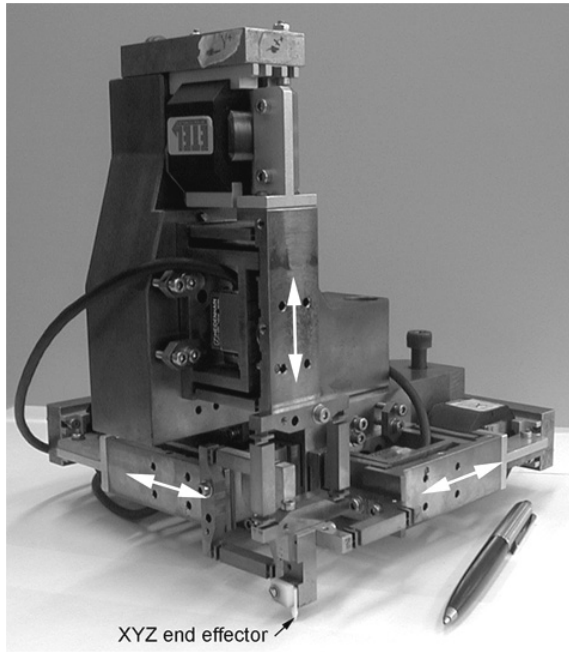
Figure 1. Delta 3 II robot (3 translational DOF, strokes: ± 2mm, resolution: 5nm) (Bacher et al., 2002).